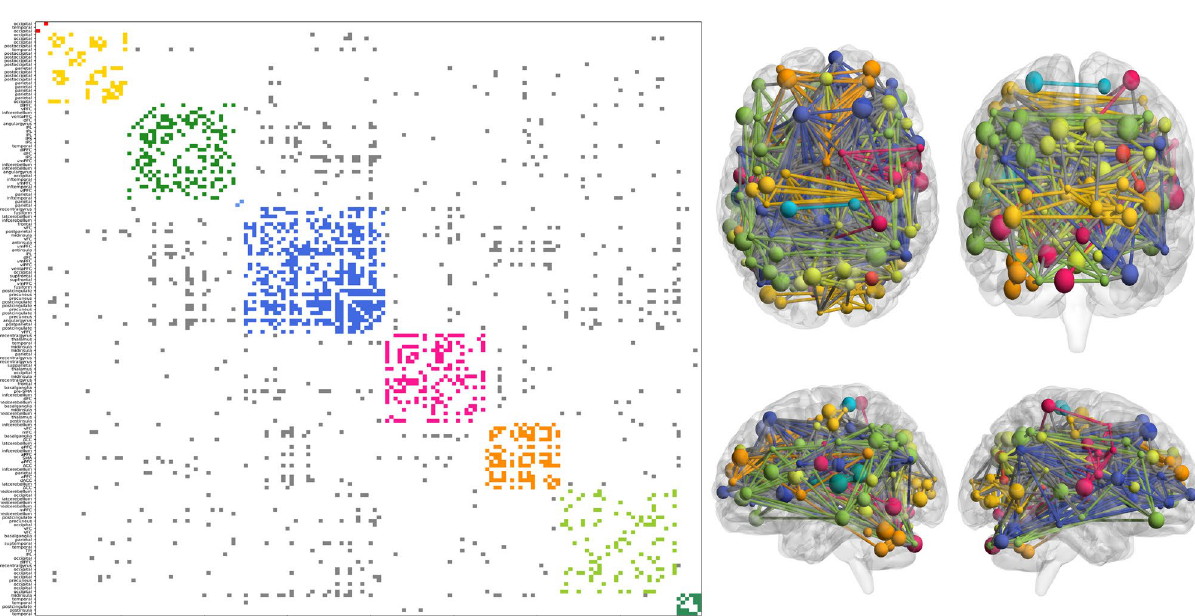
Figure 5. Graph partitioning of the communities defined by using QA for the Dosenbach atlas. Left: Reordered connectivity matrix according to module assignment. Right: Axial, coronal, and 2 hemispheres sagittal views of brain connectivity (plotted using the BrainNet Viewer Toolbox 36 ). In both cases, connections and nodes belonging to the same community are plotted using the same color code while grey edges correspond to connections between different modules. The size of the nodes is given by the